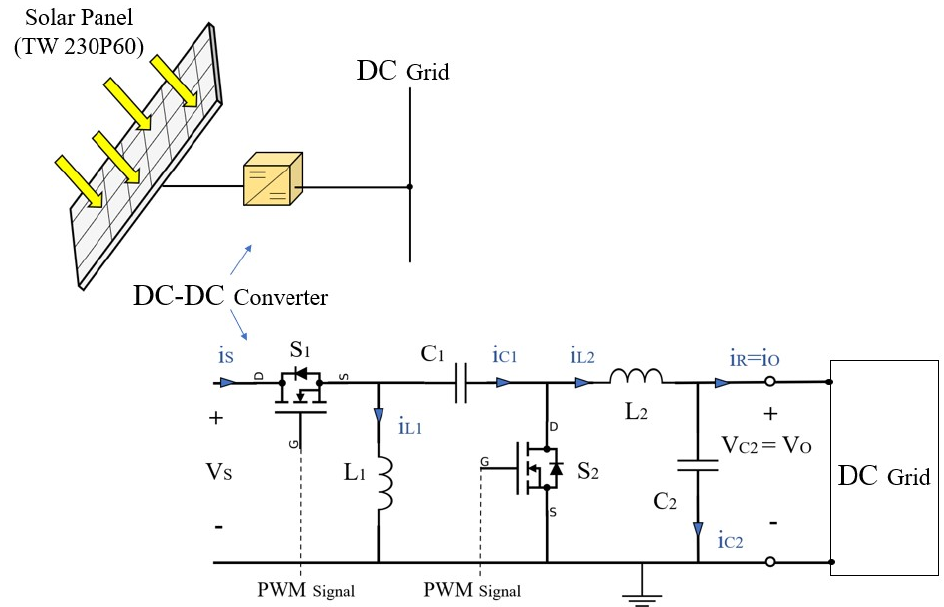
Figure 2. General diagram of the photovoltaic system and Zeta converter circuit.